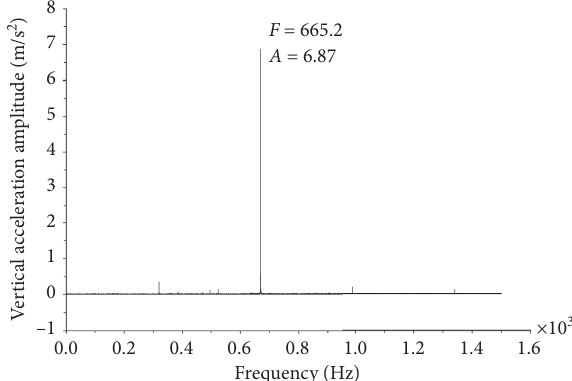
Figure 11: Vertical acceleration of the optimal model.